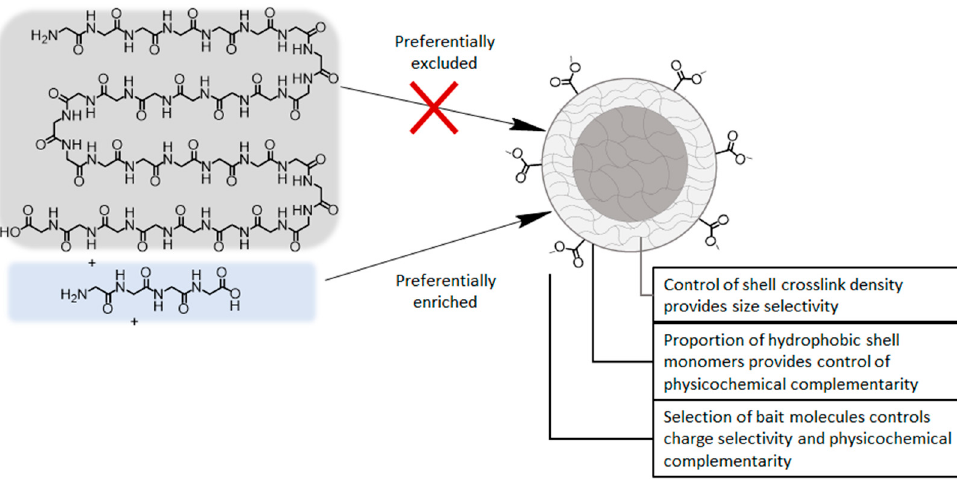
Figure 19. Concept of core–shell particle harvest. Preferential enrichment of target biomolecules, in this case, amphipathic and cationic peptides, is achieved with a particle design that provides size selectivity and physicochemical complementarity to targets.